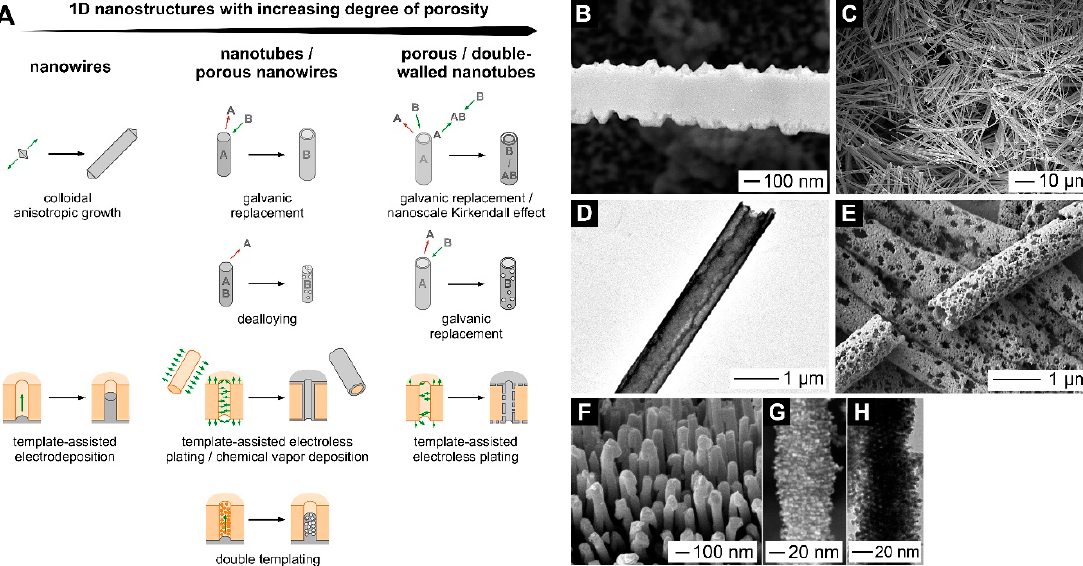
Figure 5. ( A ) Scheme of synthetic approaches toward 1D metal nanostructures, ordered by their degree of porosity. The green arrows indicate metal deposition, the red arrows metal dissolution. On the right, electron micrographs of representative nanostructures created with the named approaches are shown: ( B ) Jagged Ag nanobelt, obtained by colloidal anisotropic growth, based on the solution chemistry outlined in [44]. ( C ) Ag nanotubes, electrolessly deposited in ion-track etched polycarbonate templates, prepared according to [67]. ( D ) Double-walled Ag-Pt nanotube, prepared by galvanic replacement, according to [61]. ( E ) Ag nanotubes, which have been subjected to galvanic replacement with Au to create porous Ag-Au nanotubes, prepared according to [67]. ( F – H ) Mesoporous Pt nanowires, prepared with the double templating strategy, reprinted (adapted) with permission from [70]. Copyright (2008) American Chemical Society.